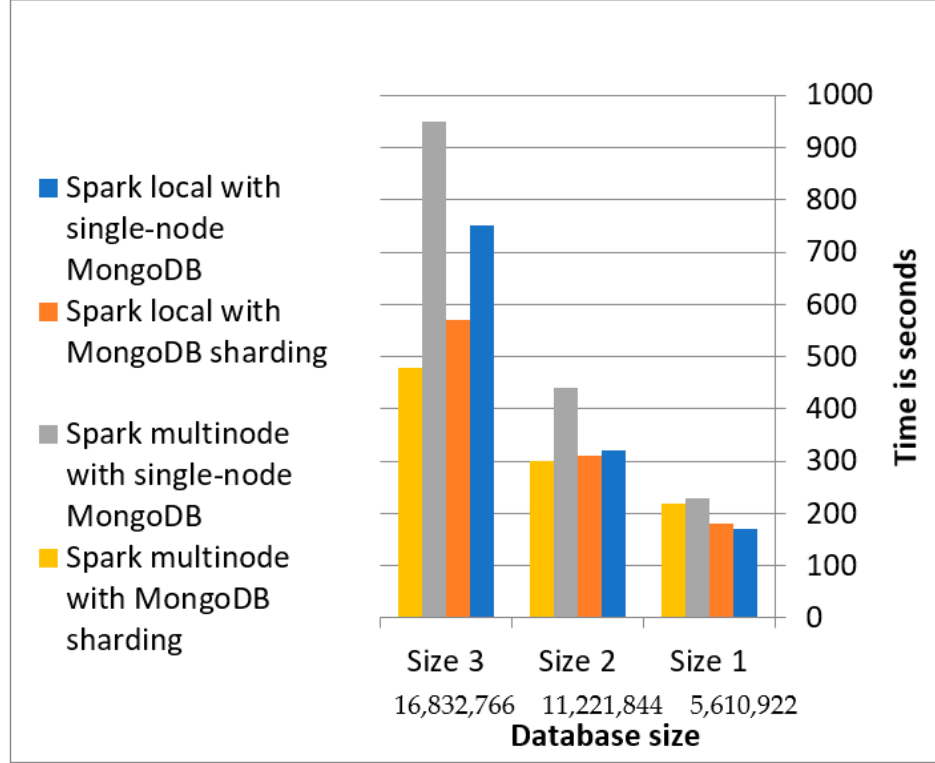
Figure 8. Elapsed time for migrating data to MongoDB using the proposed layer.